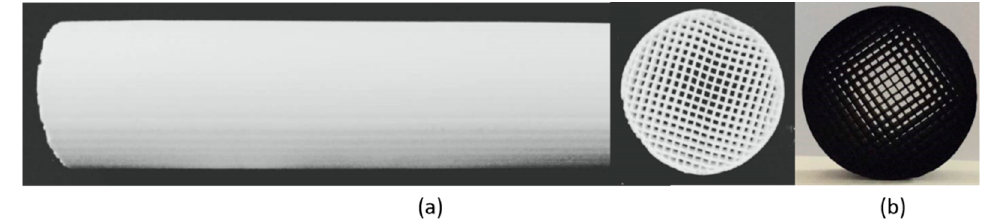
Figure 9. ( a ) Bare cordierite monolith and ( b ) CNT-coated monolith.